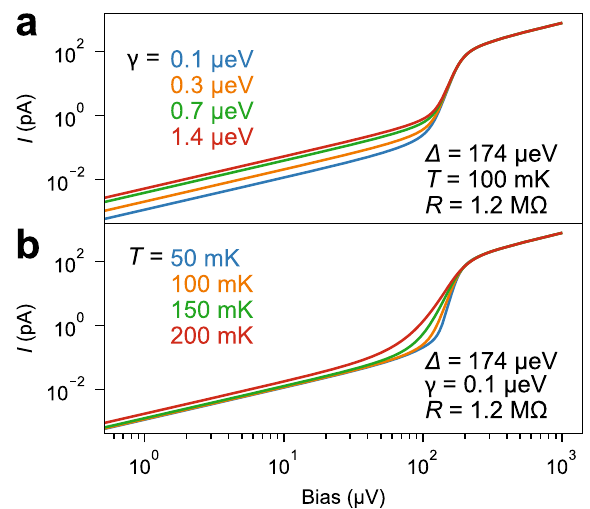
Fig. 7 In fl uence of the temperature T and the Dynes parameter γ on I ( V ) curves simulated using the Dynes expression Eq. (6). a The I ( V ) curves obtained by varying γ . b The I ( V ) curves obtained by varying T . The values of the respective parameters are listed in the legend of each panel. R stands for the high-voltage or normal-state resistance of the junction. Δ is the superconducting gap